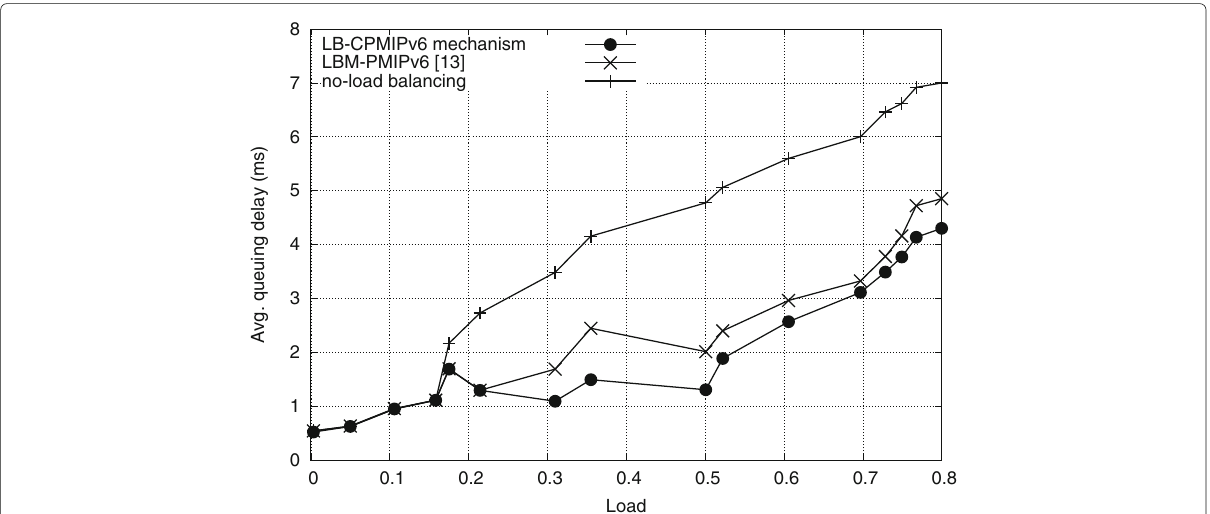
Fig. 13 The average queuing delay obtained from scenario